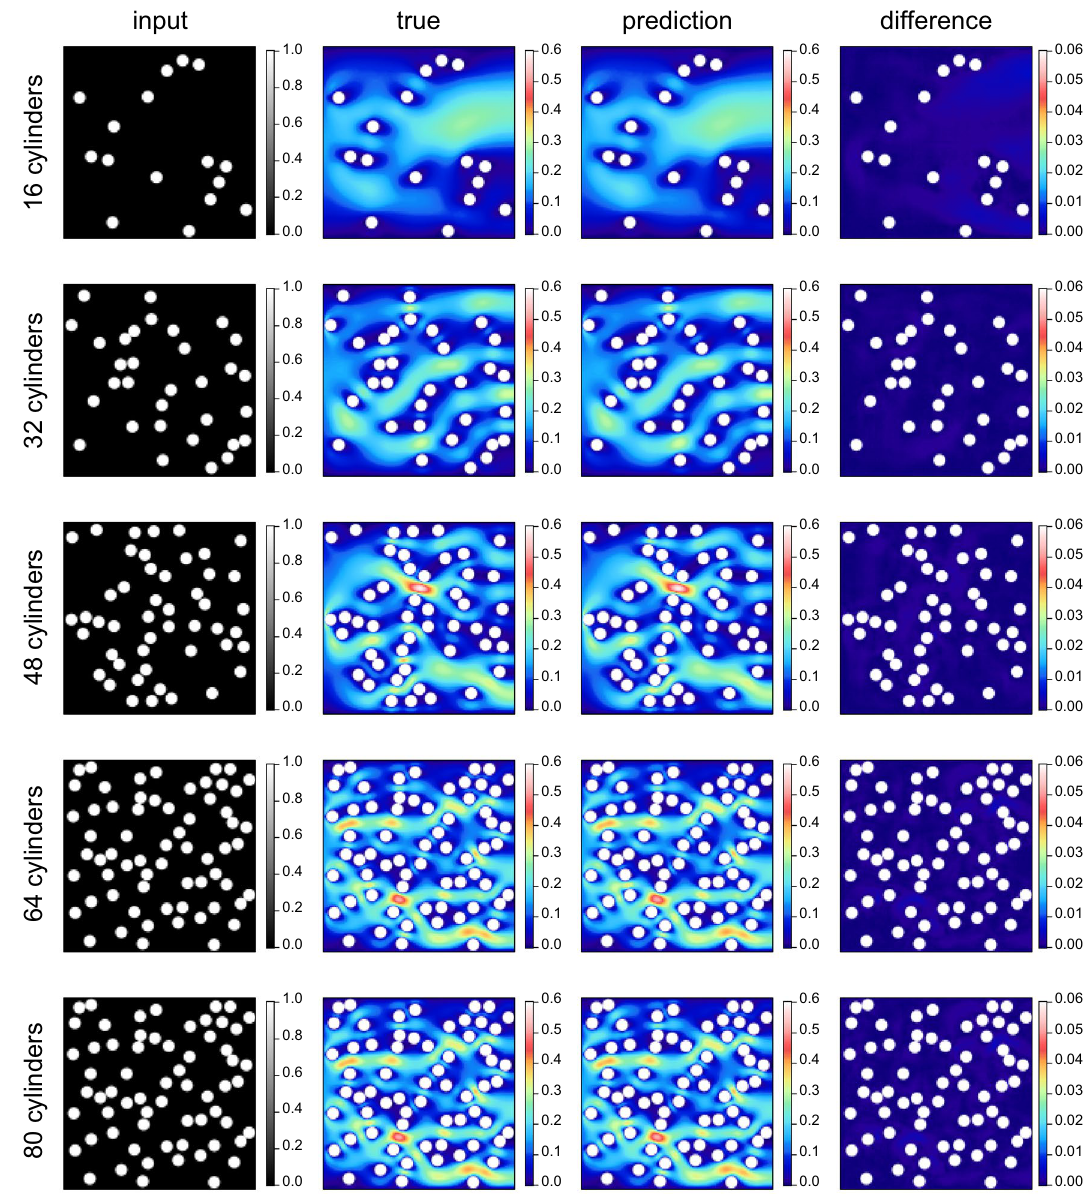
Figure 4. Comparison of the true and predicted velocity fields for unknown cylinder systems that are not learned in the training and validation datasets. The leftmost column shows the input data (the smoothed profile function φ ). The rest, from left to right, show the magnitude of the true velocity, predicted velocity, and difference between the true and predicted velocities. The rows from top to bottom respectively show the results for the systems with 16, 32, 48, 64, and 80 cylinders. To make the cylinder position easier to see, the velocity values defined in the cylinder domain are shown in